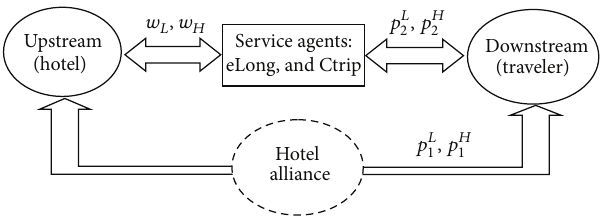
Figure 1: Tourism dual-channel supply chain model